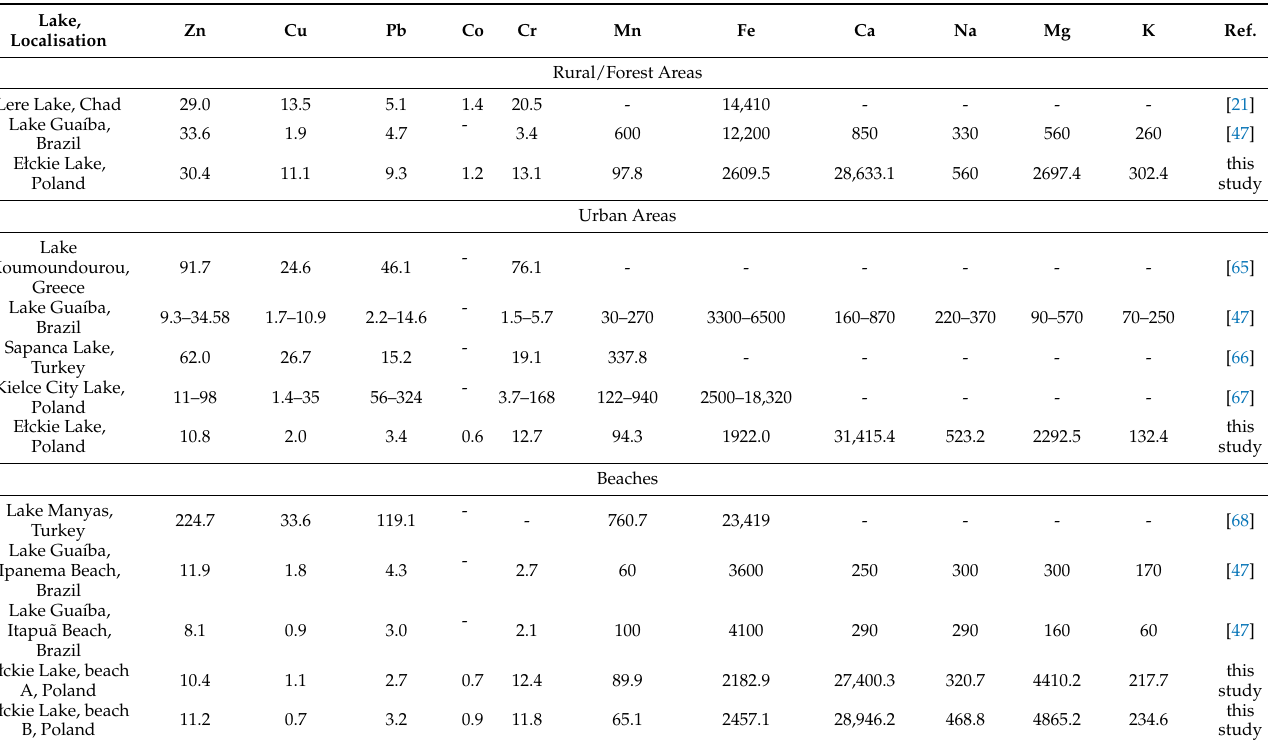
Table 4. Means/ranges of metal concentrations in coastal lake sediments in different areas of the world (dash “-“—not